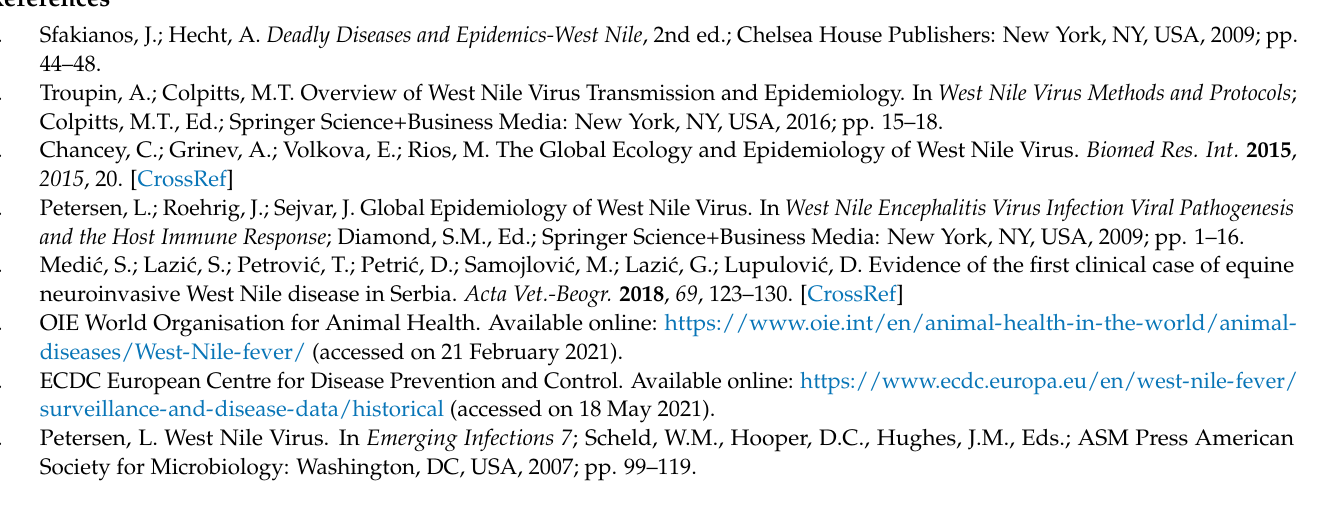
2020, Table S16: Results of a negative binomial regression analysis of the influence of the minimum the Danube river water level fluctuations on the number of registered cases of WNV in humans, Table S17: Results of a negative binomial regression analysis of the influence of the Danube river average water level fluctuations on the number of registered cases of WNV in humans, Table S18: Results of a negative binomial regression analysis of the influence of the Danube river maximum water level fluctuations on the number of registered cases of WNV in humans, Table S19: Results of a negative binomial regression analysis of the influence of the Danube river maximum water level fluctuations and average minimum environmental temperatures on the number of registered WNV positive mosquito positive pools, Table S20: Distribution and length of the period of blowing of the prevailing winds in hours of blowing. Climatology, land cover of South Banat district, and statistical analyses on the effects of air temperature fluctuations and river water levels on the number of registered cases of WNV in humans and